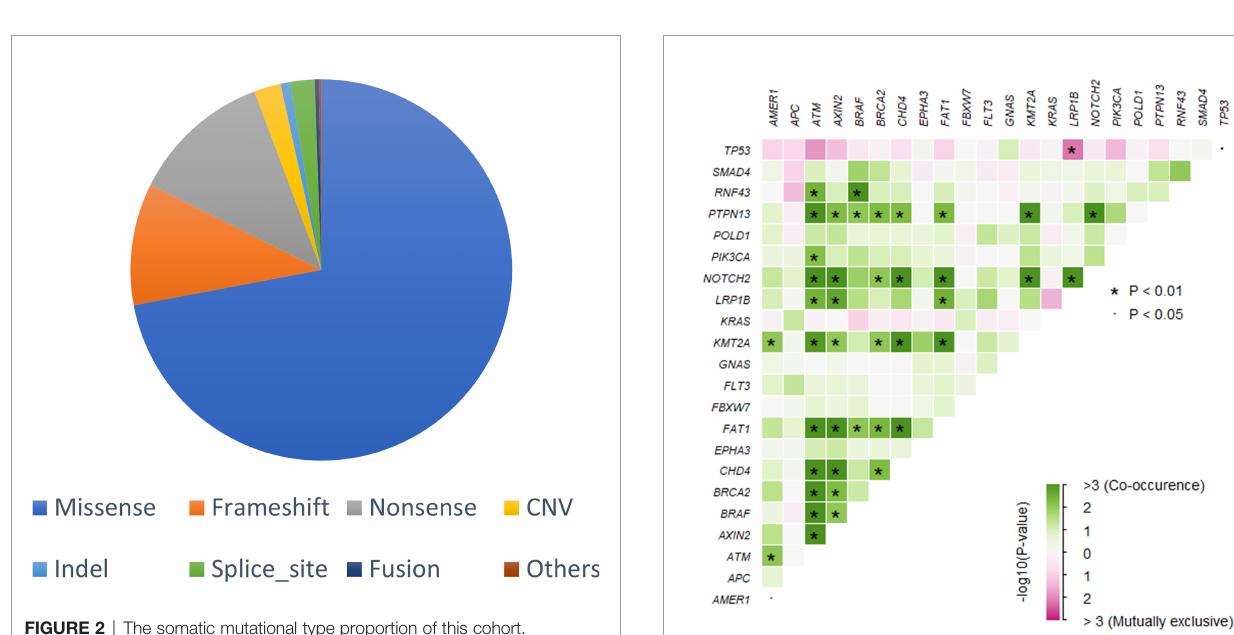
Table 1 ). Speci fi cally, mutations of fi ve genes favored non-lymph metastasis, namely ATM (8/28 vs. 2/56, p <0.01), CHD4 (7/28 vs. 2/ 56, p <0.01), AMER1 (9/28 vs. 5/56, p = 0.01), KMT2A (7/28 vs. 3/ 56, p = 0.01), and NOTCH2 (7/28 vs. 3/56, p = 0.01). On the other hand, TP53 mutations were enriched in the lymph metastasis group (19/28 vs. 51/56, p = 0.01). Moreover, a comparison between patients older or younger than median age was performed and showed that mutations in KDR (7/44 vs. 0/41, p = 0.01) were more common in the younger patients while mutations in ARAF (0/44 vs.